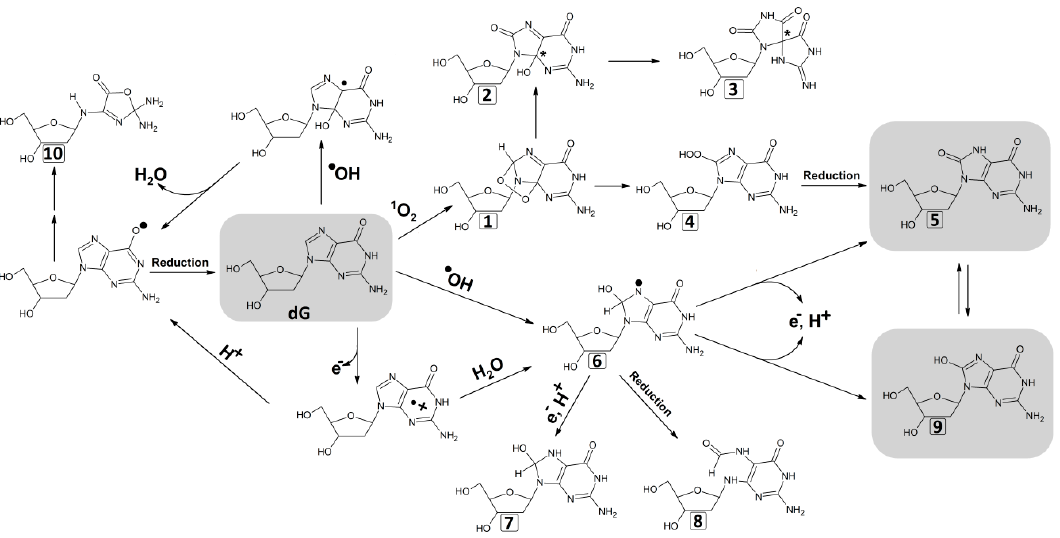
Figure 2. Generation of 8-oxo-7,8-dihydro-2 (cid:48) -deoxyguanosine and 8-Hydroxy-2 (cid:48) -deoxyguanosine [61]. 2 (cid:48) -deoxyguanosine ( dG ), 4,8-endoperoxide-2 (cid:48) -deoxyguanosine ( 1 ), 4 R / 4 S 4-Hydroxy-8-oxo-4,8-dihydro- 2 (cid:48) -deoxyguanosine ( 2 ), 4 R / 4 S spiroiminodihydantoin nucleoside ( 3 ), 8-Hydroperoxy-2 (cid:48) -deoxyguanosie ( 4 ), 8-oxo-7,8-dihydro-2 (cid:48) -deoxyguanosine ( 5 ), 8-Hydroxy-7,8-dihydro-2 (cid:48) -deoxyguanosyl radical ( 6 ), 7-Hydro-8-Hydroxy-2 (cid:48) -deoxyguanosine ( 7 ), 2,6-diamino-4-Hydroxy-5-formamidopyrimidine (FapyGua) ( 8 ), 8-Hydroxy-2 (cid:48) -deoxyguanosine ( 9 ), oxazolone ( 10 ).